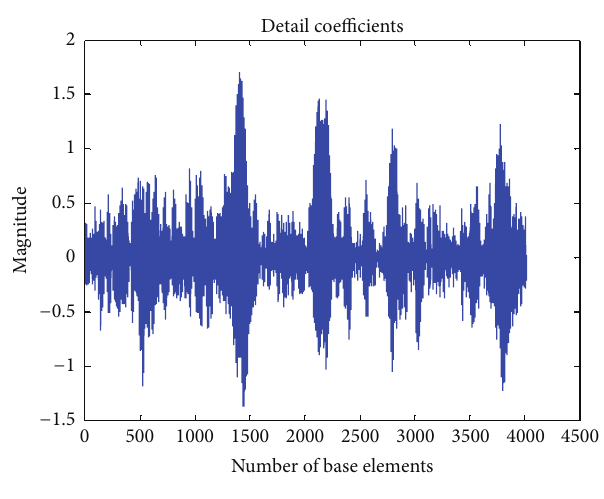
Figure 7: Detail coefficients of DWT.